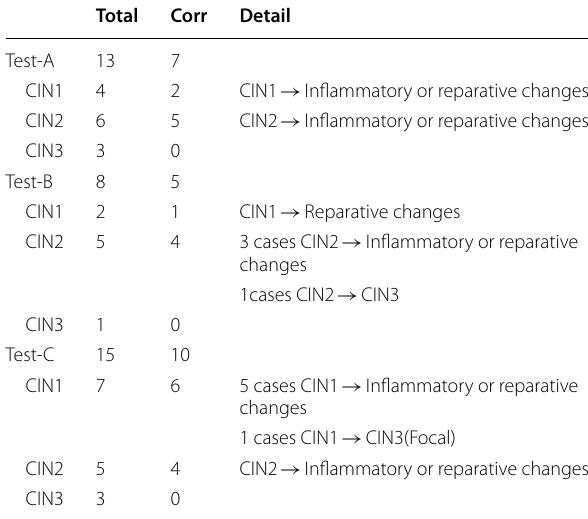
Table 5 The number and details of corrected diagnosis cases in each test